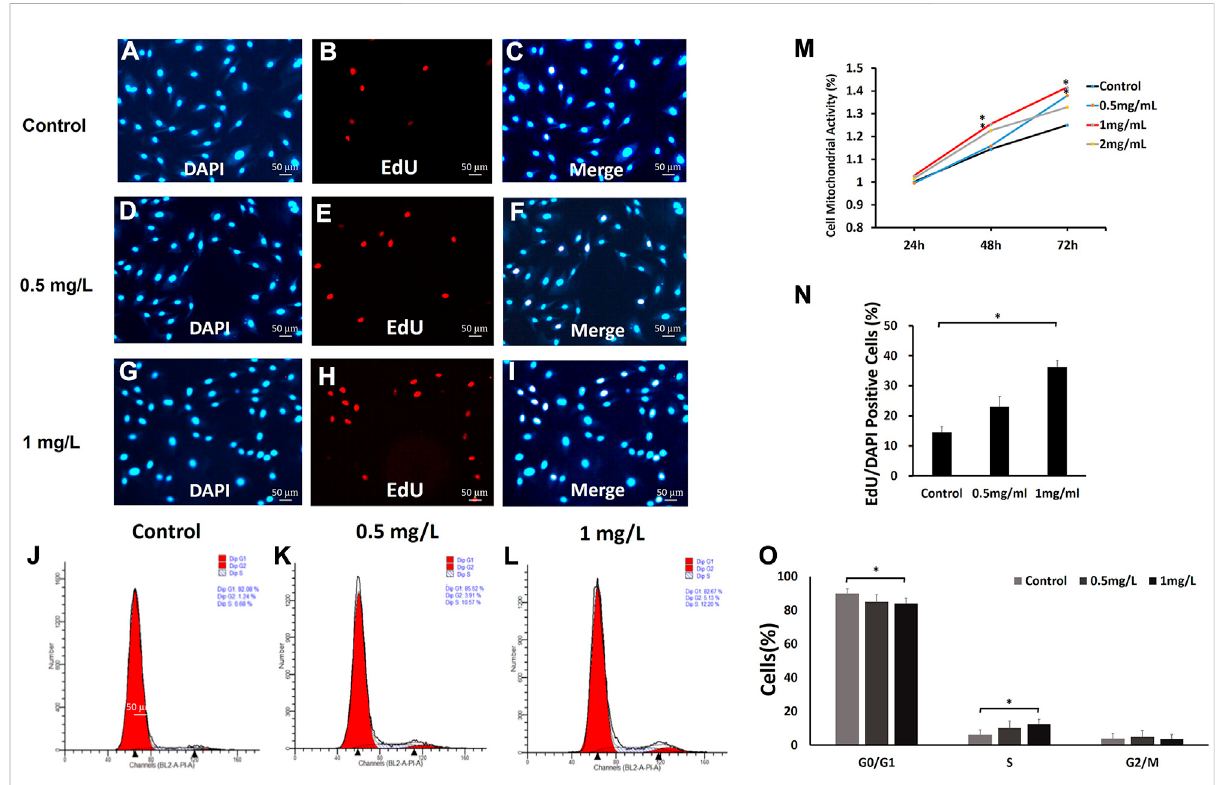
FIGURE 5 The effects of COS on mitochondrial activity, proliferation and cell cycle of fi broblasts (A – L,N,O) The fi broblasts were treated with 0, 0.5, and 1.0 mg/mlCOSfor24and72 h,and1.0 mg/mlCOSsigni fi cantlypromotedcellproliferation. (M) TheMTTassaysshowedthatthemitochondrialactivity ofcellsstimulatedwithCOSat0.5 mg/mland1 mg/mlwassigni fi cantlyhigherthanthatofthecontrolgroup.* p < 0.05.Thescalebarrepresents50